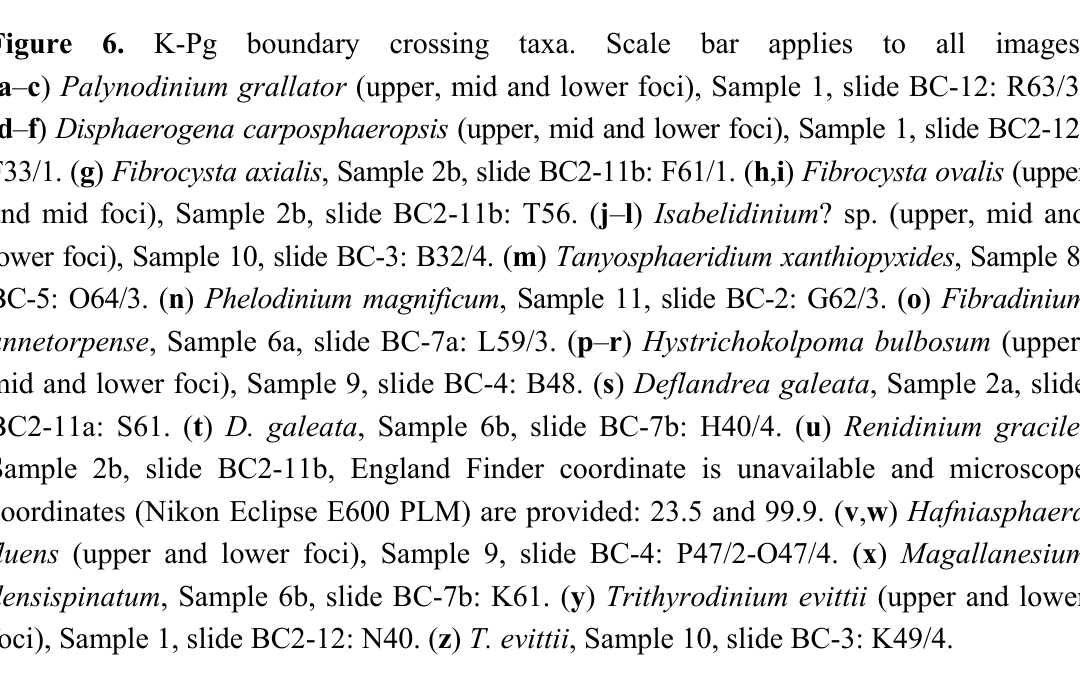
Figure 6. K-Pg boundary crossing taxa. Scale bar applies to all